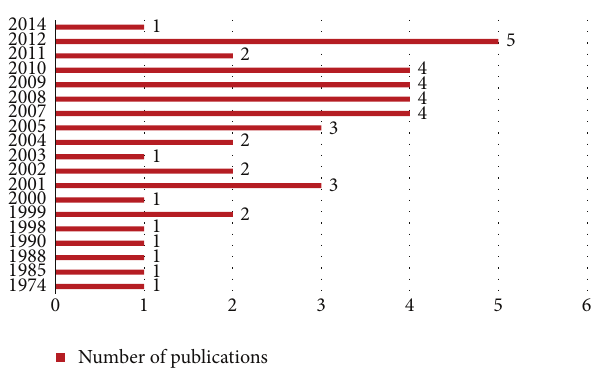
Figure 1: Number of publications per